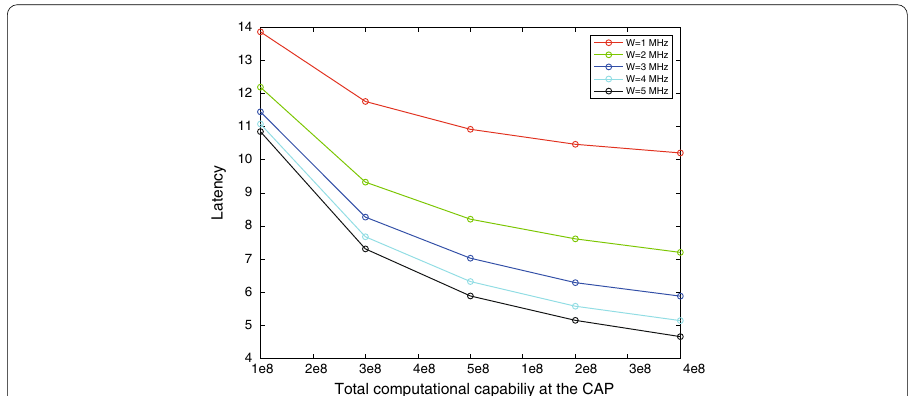
Fig. 6 Effect of the total calculating capability of CAP on the system latency of the proposed